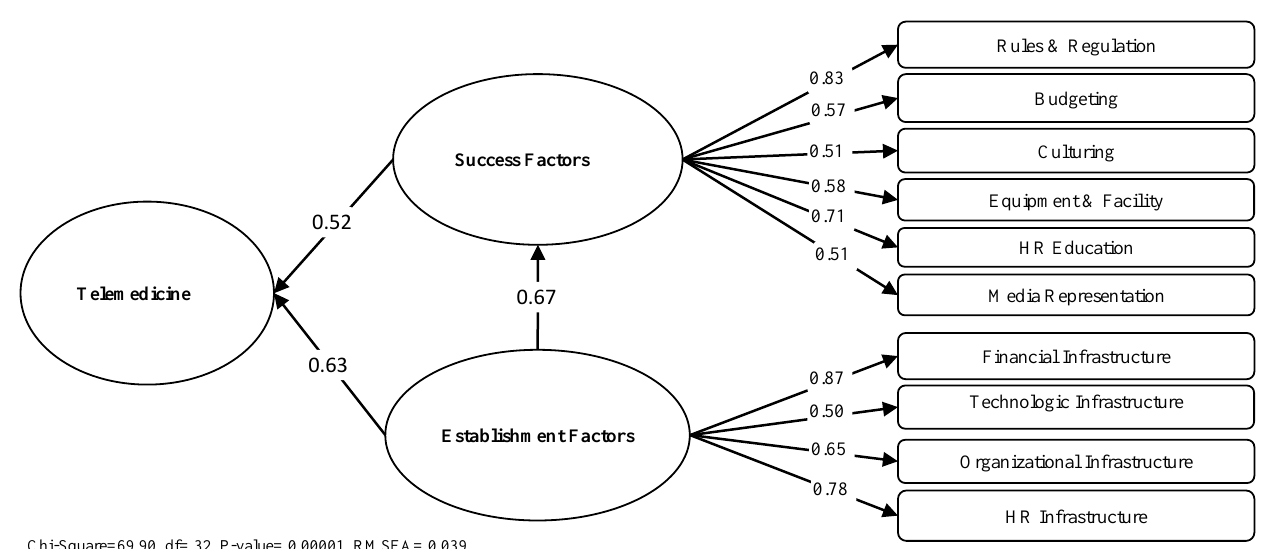
Figure 1. Fitness of the conceptual model - Structural part (standard)